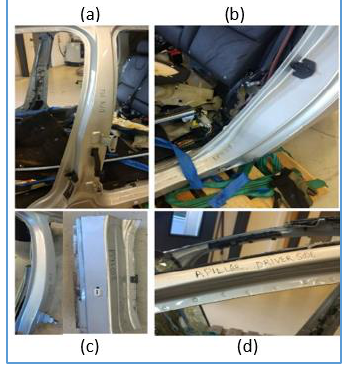
Fig. 2. Vehicle structural members using Fig. 3. Dimensions of the specimen used in the